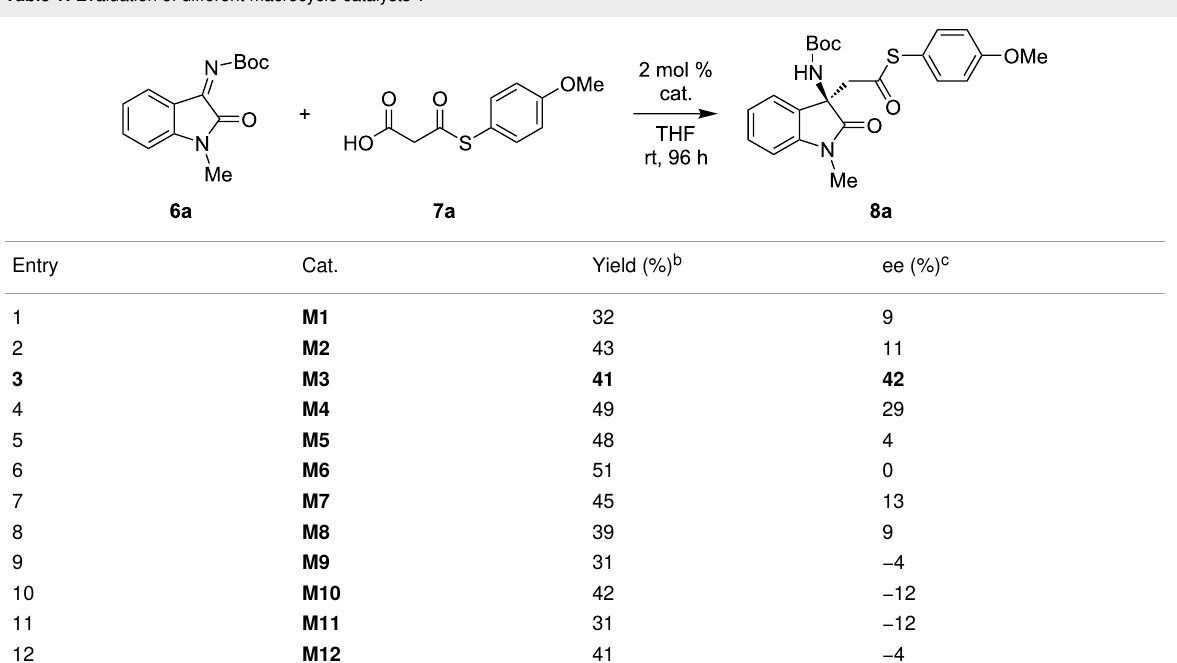
Table 1: Evaluation of different macrocycle catalysts a